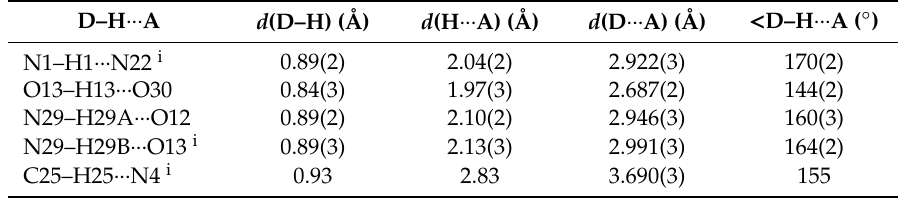
Table 4. Table 4. Hydrogen bonding interactions in the crystal structure of lorazepam co-crystals with nicotinamide.